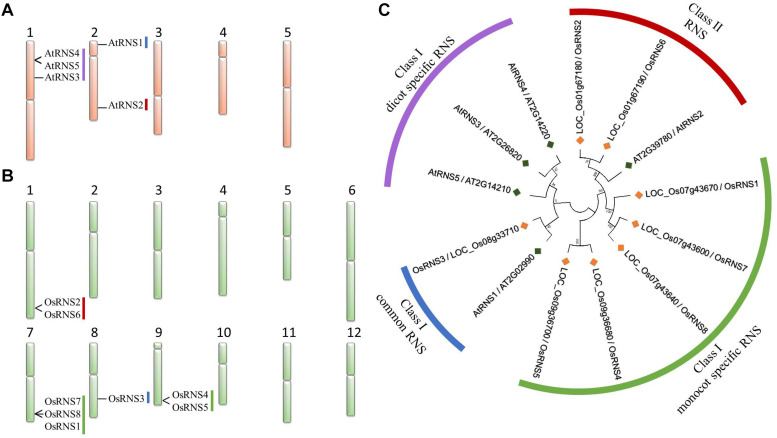
Chromosome map and phylogenetic tree of rice and Arabidopsis RNS family genes. The chromosome map of Arabidopsis RNS family genes (A) and rice RNS family genes (B). Phylogenetic tree of the RNS family comprising eight rice (Oryza sativa) and five Arabidopsis RNS proteins (C). The phylogenetic tree was built using the neighbor-joining method with a bootstrap value of 1000 using MEGA 7.